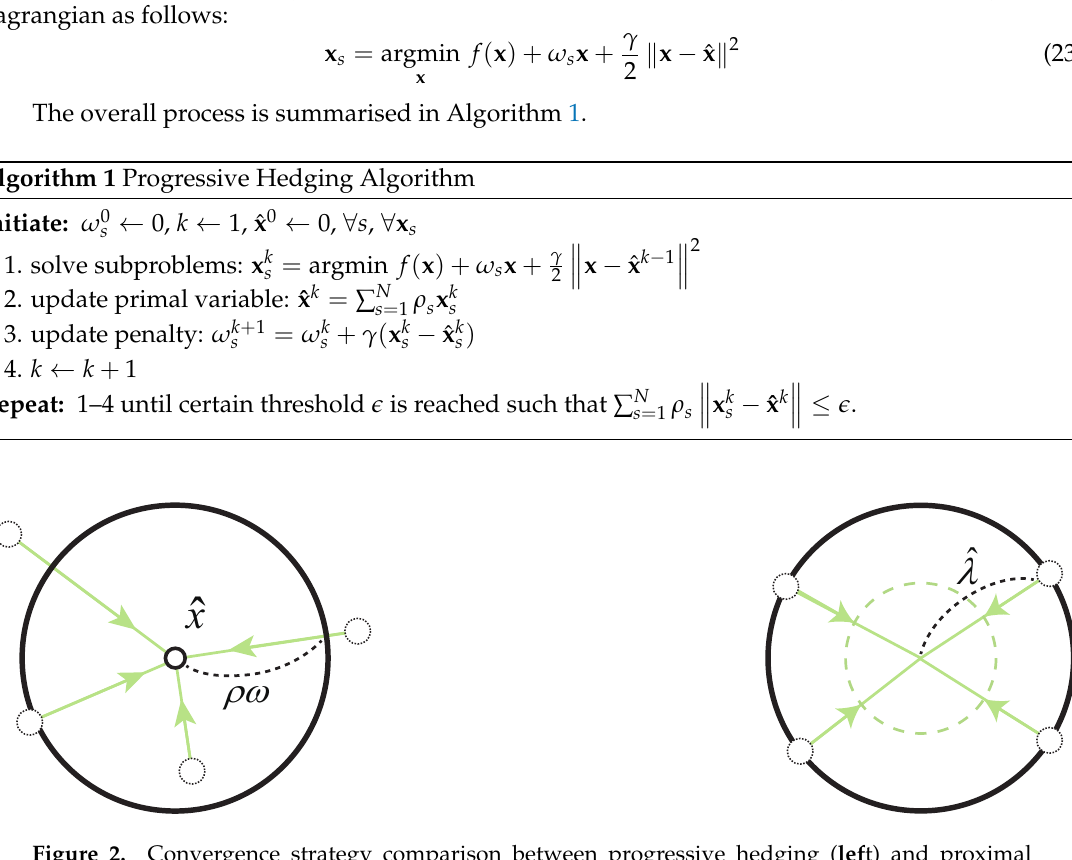
Figure 2. Convergence strategy comparison between progressive hedging ( lef t) and proximal bundle ( right